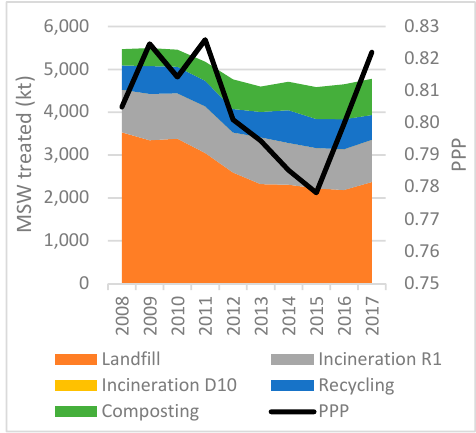
Figure 44. Waste treatment methods and PPP in Portugal 2008–2017 (European Statistics 2019b, 2019c).